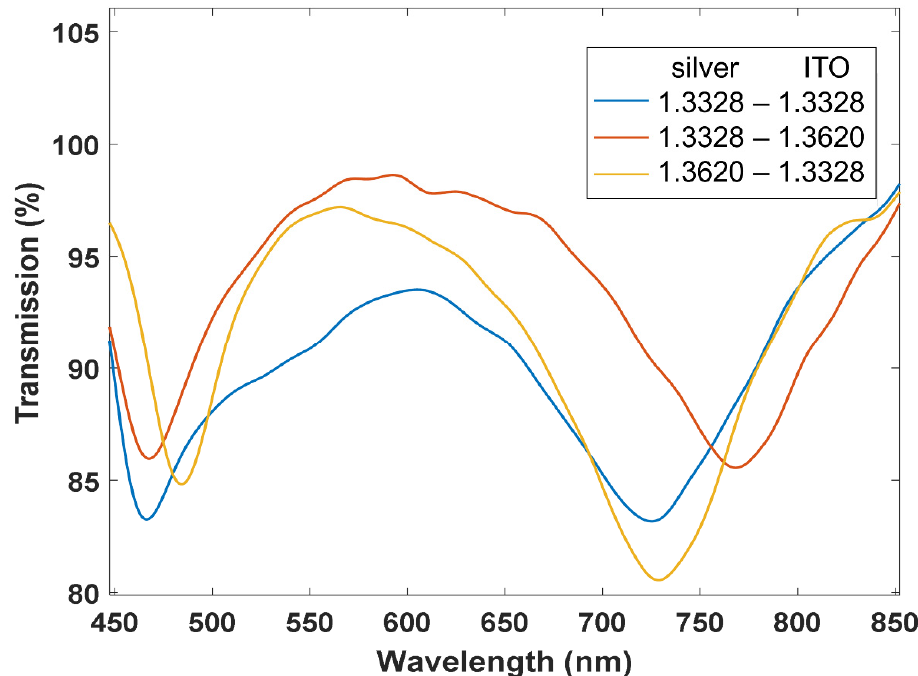
Figure 7. Transmission spectra (TM polarization) when both the silver and the ITO coated are covered by the same refractive index (1.3328-1.3328, blue line), when the silver coated region is immersed in refractive index 1.3328 and the ITO coated region in 1.362 (red line), and when the silver coated region is immersed in refractive index 1.362 and the ITO coated region in 1.3328 (yellow line).